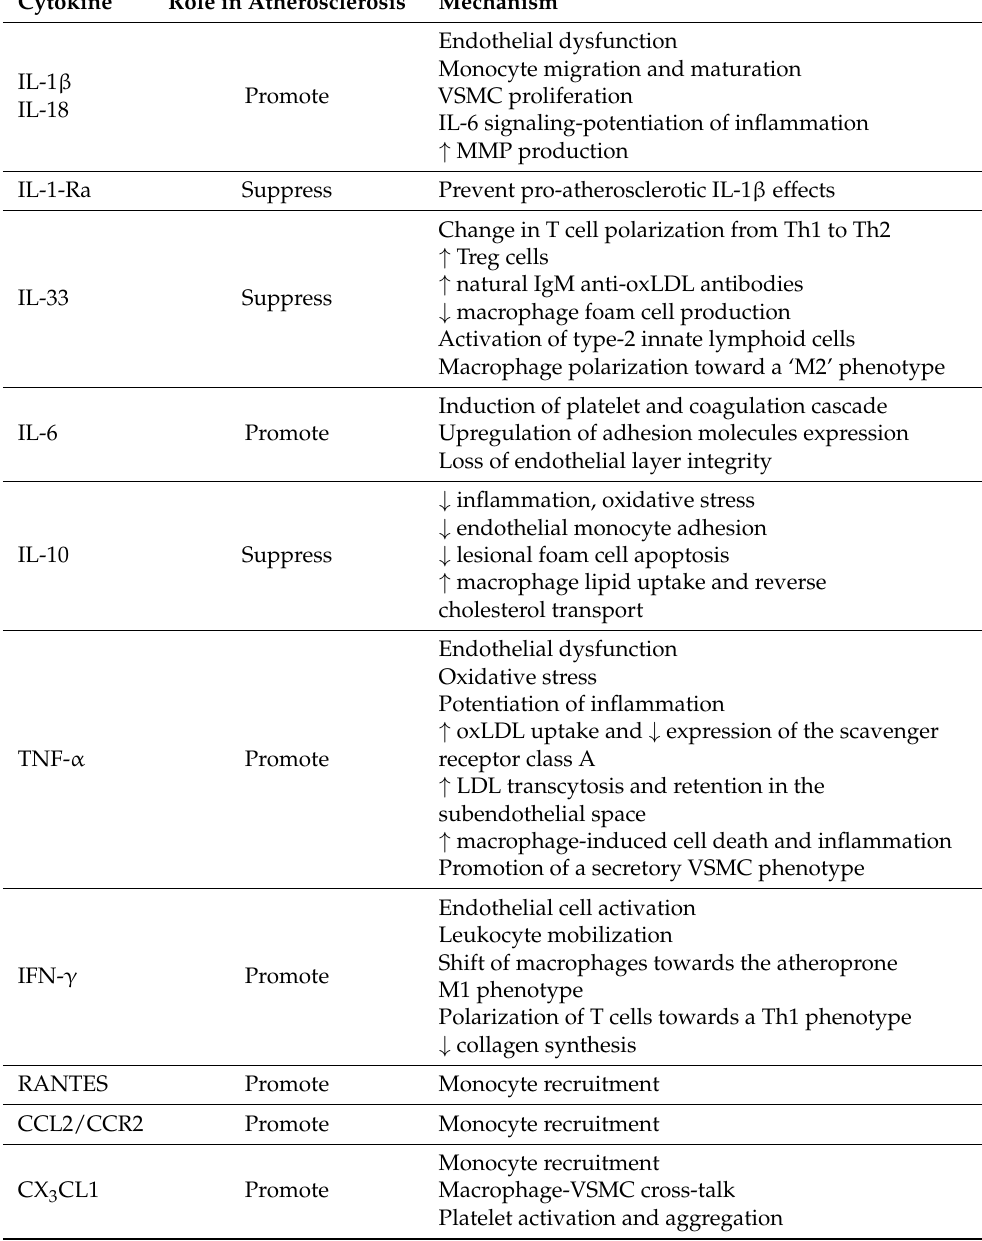
Table 1. Role and mechanism of action of various cytokines in